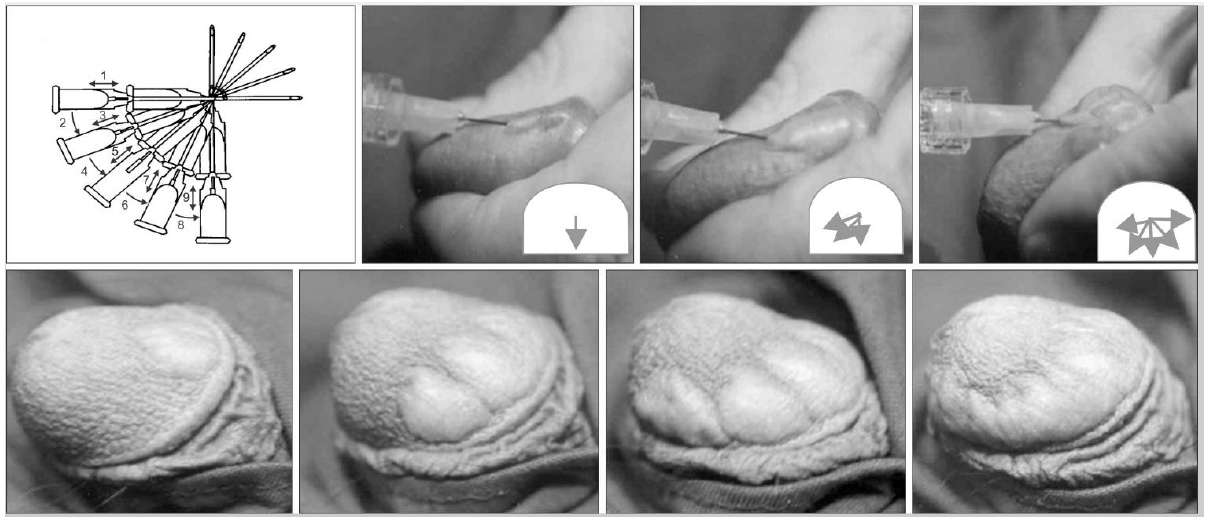
Figure 2. The “fan” technique. Images reused from Moon et al. [13], which is distributed under the